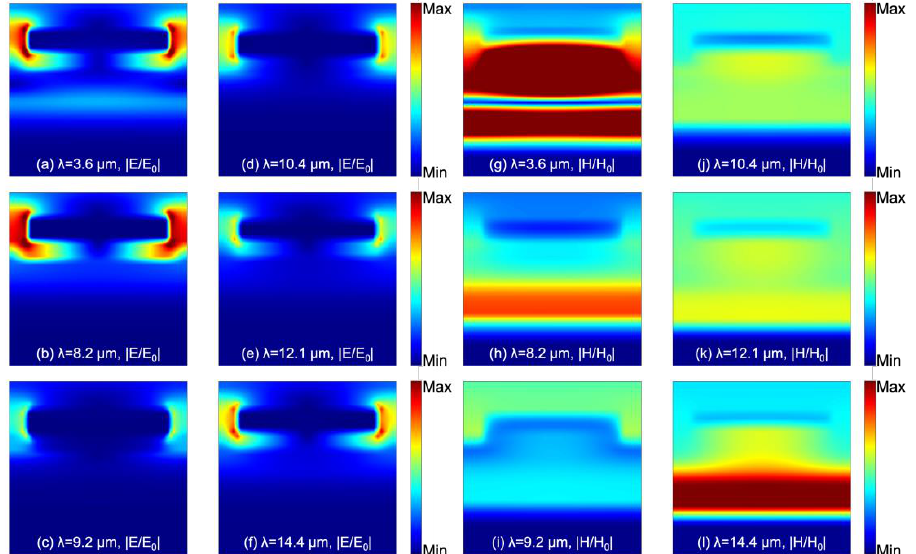
Figure 4. Electric field distribution of S3 at ( a ) λ = 3.6 µ m, ( b ) λ = 8.2 µ m, ( c ) λ = 9.2 µ m, ( d ) λ = 10.4 µ m, ( e ) λ = 12.1 µ m, and ( f ) λ = 14.4 µ m. The color bar indicates the relative electric field intensity (E/E 0 ). Magnetic field distribution at ( g ) λ = 3.6 µ m, ( h ) λ = 8.2 µ m, ( i ) λ = 9.2 µ m, ( j ) λ = 10.4 µ m, ( k ) λ = 12.1 µ m, and ( l ) λ = 14.4 µ m. The color bar indicates the relative magnetic field intensity (H/H 0 ).